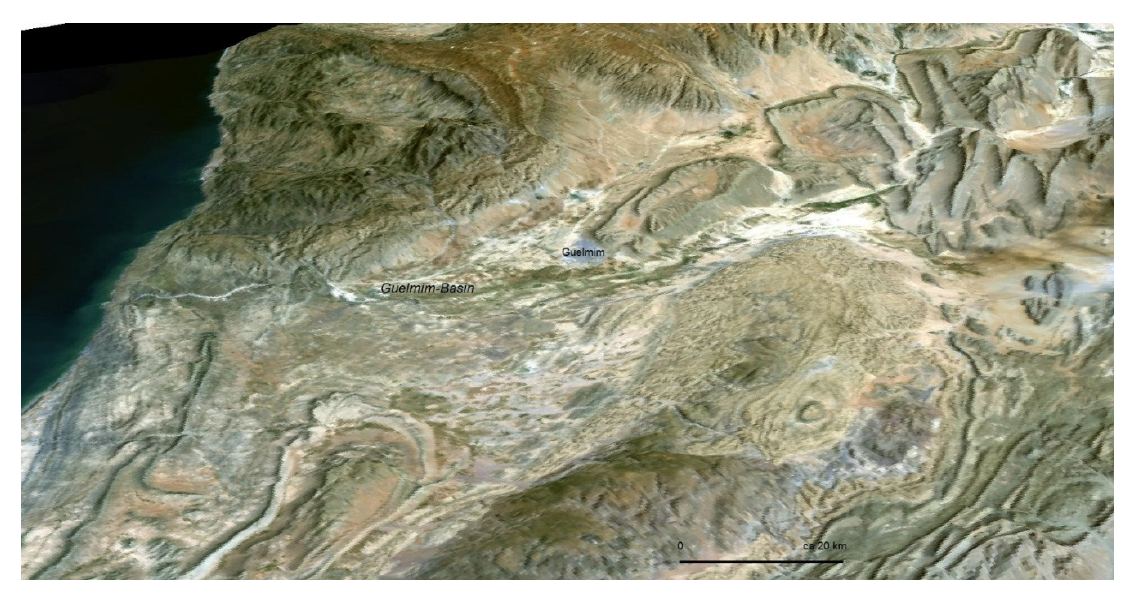
Figure 4. Perspective 3D view of a Landsat 8 image merged with ASTER DEM data of the Guelmim area facing